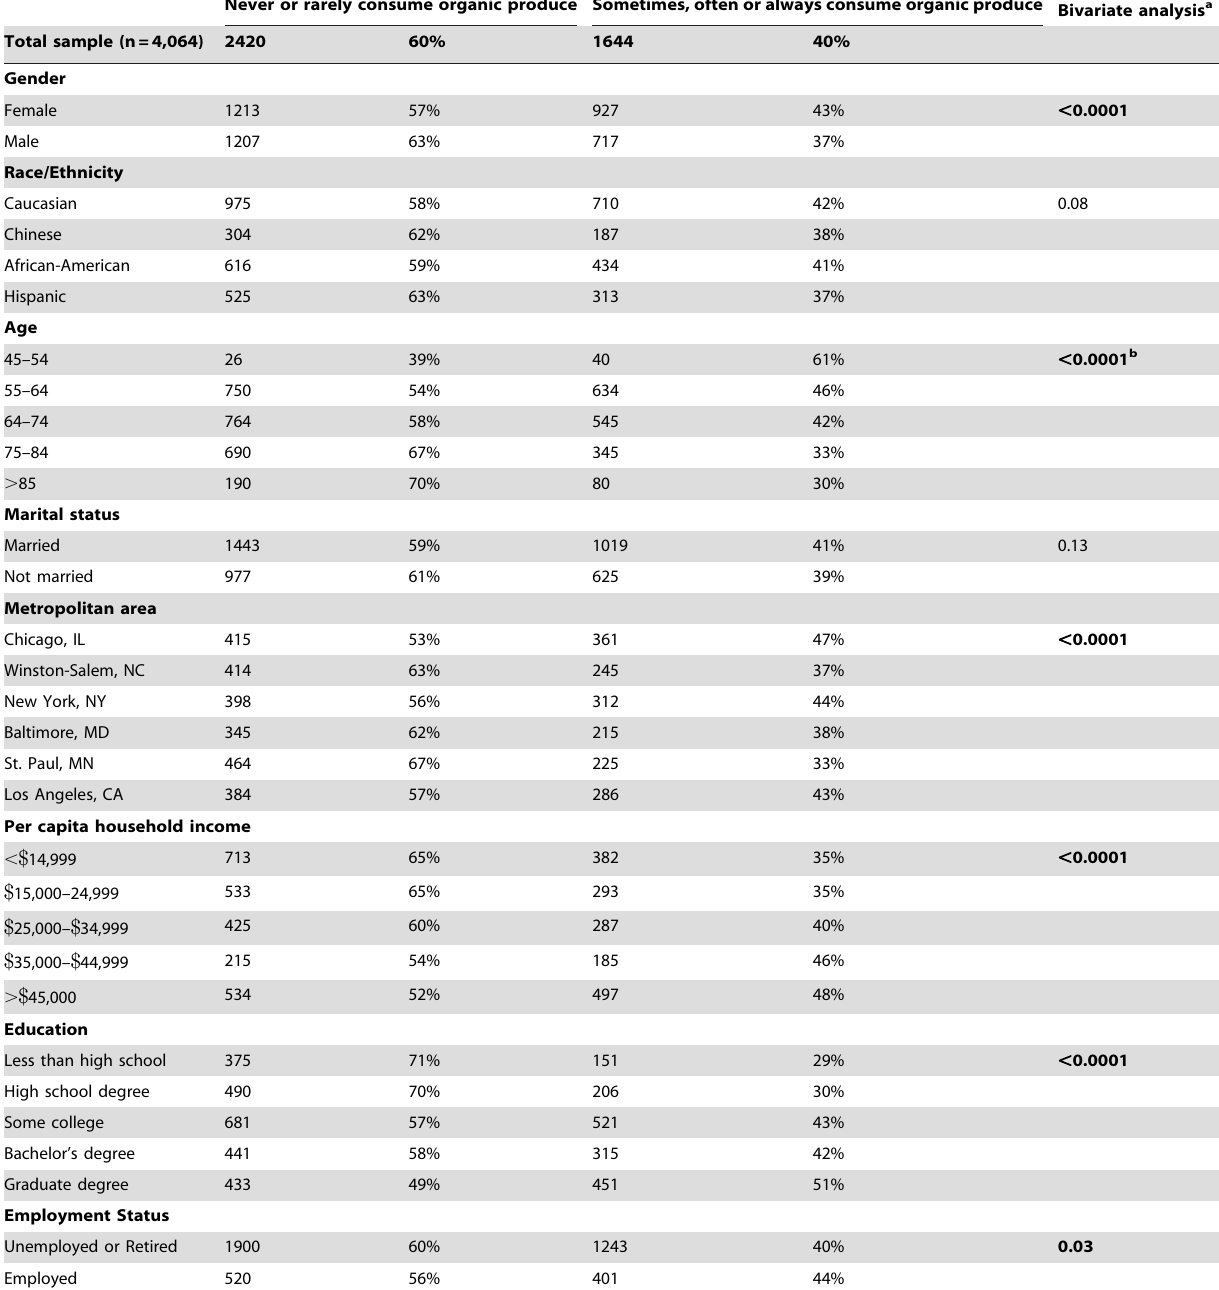
Table 1. Demographic and socioeconomic characteristics of the Multi-Ethnic Study of Atherosclerosis cohort at Exam 5 (2010– 2012), by organic produce consumption